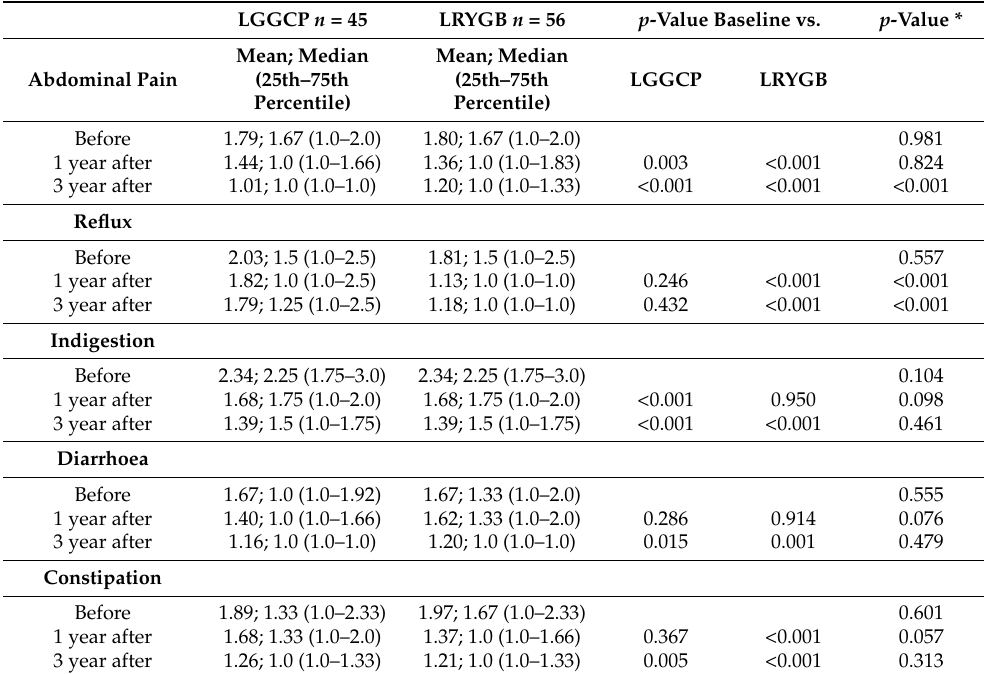
Table 6. Distribution of results of the Gastrointestinal Symptom Rating Scale before and 1 year and 3 year after